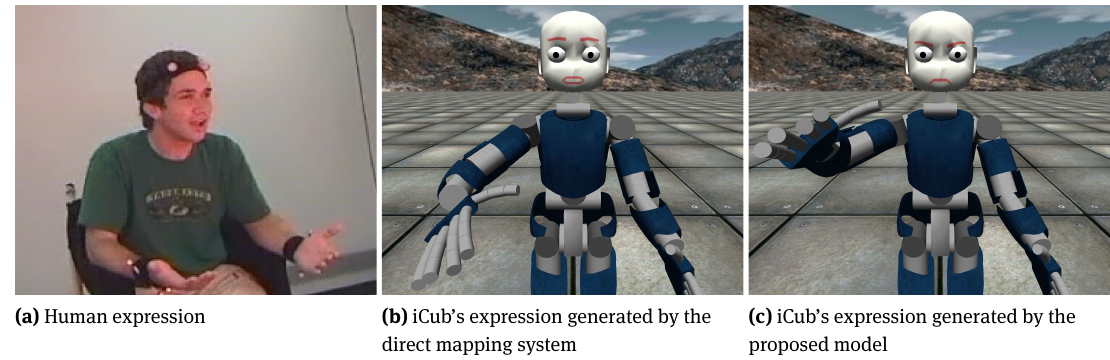
Figure 5: Example of expressions obtained in imitation experiments from the direct mapping system or the proposed model. In figure (a), the human expressed angry emotion in the interaction. Note that the model did not learn the expressions of the human.